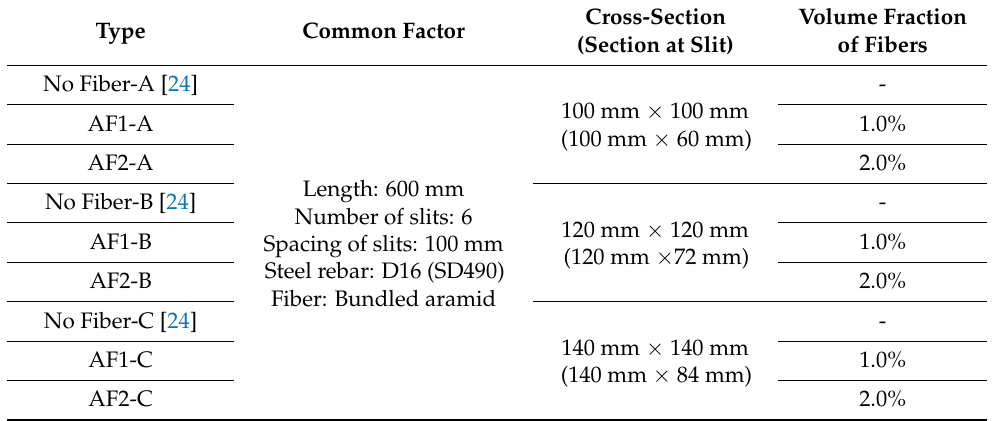
Table 2. List of specimens.